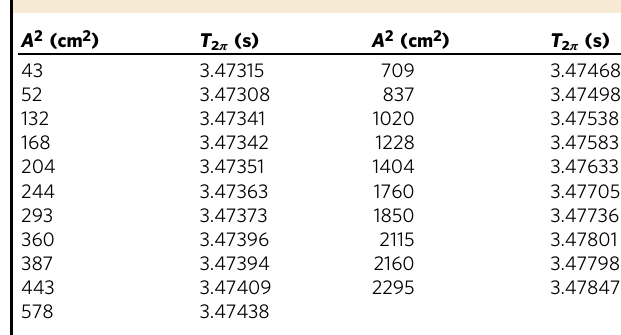
Table 1 Measured data of the time-period of a pendulum as a function of its amplitude extracted from ref. 26